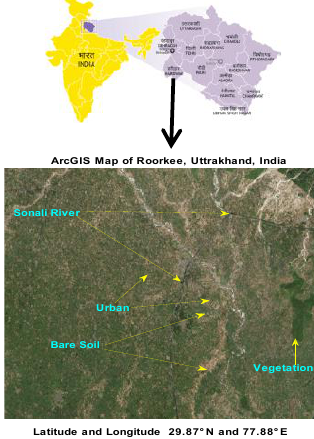
Fig.5 India (Bharat) (cid:198) Uttarakhand (cid:198) Location of the Roorkee